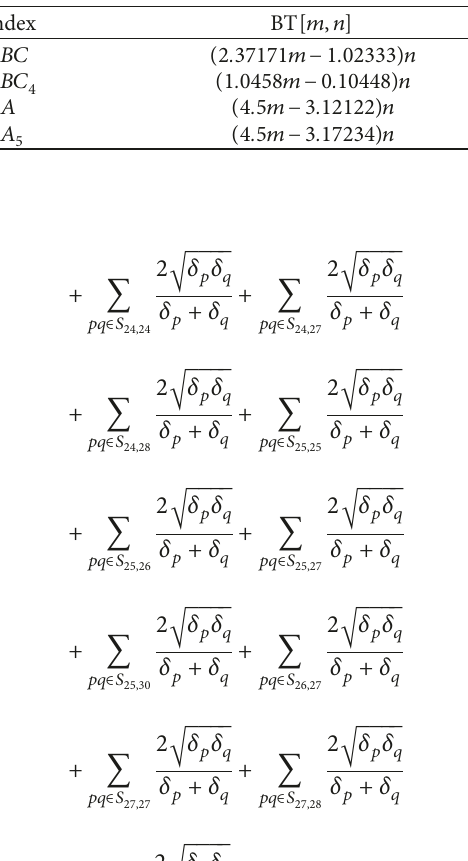
Table 2: Degree-based topological indices of boron